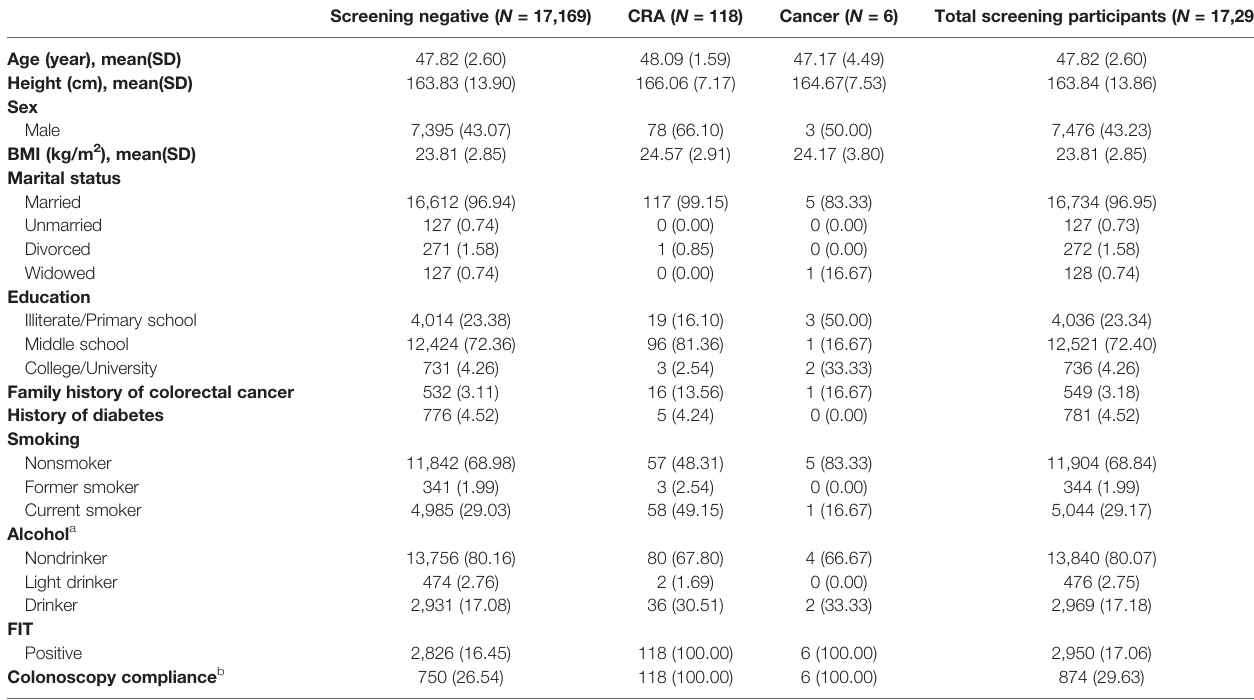
BMI, body mass index; CRA, colorectal adenoma; FIT, fecal immunochemical test; SD, standard deviation. a Alcohol drinking was classi fi ed as nondrinker, light drinker (<1 time per month for more than 6 months), and drinker ( ≥ 1 time per month for more than 6 months). b Colonoscopy compliance means the participation rate of colonoscopy among those with positive FIT